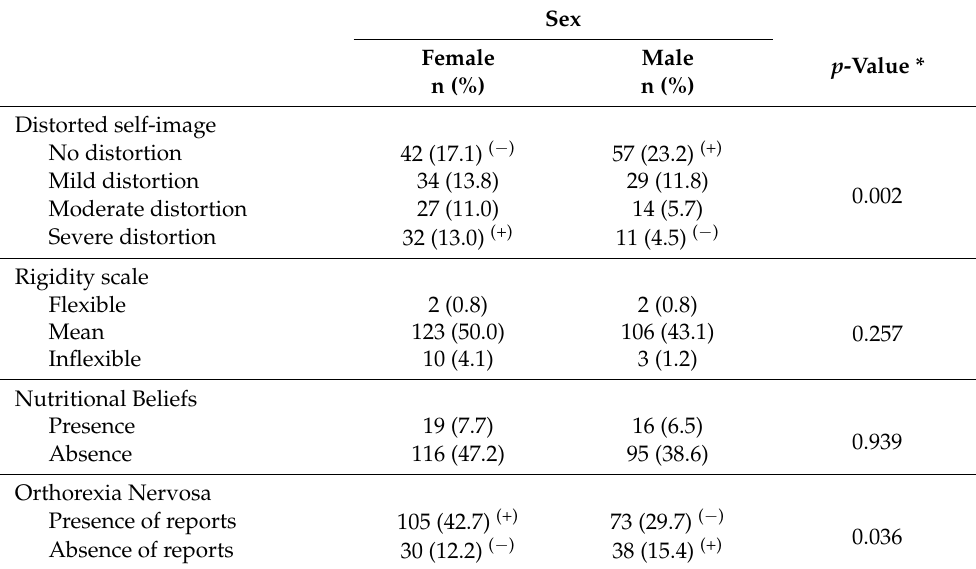
Table 2. Comparison between the variables studied according to the presence or absence of reports of orthorexia by students from a Brazilian Public University.